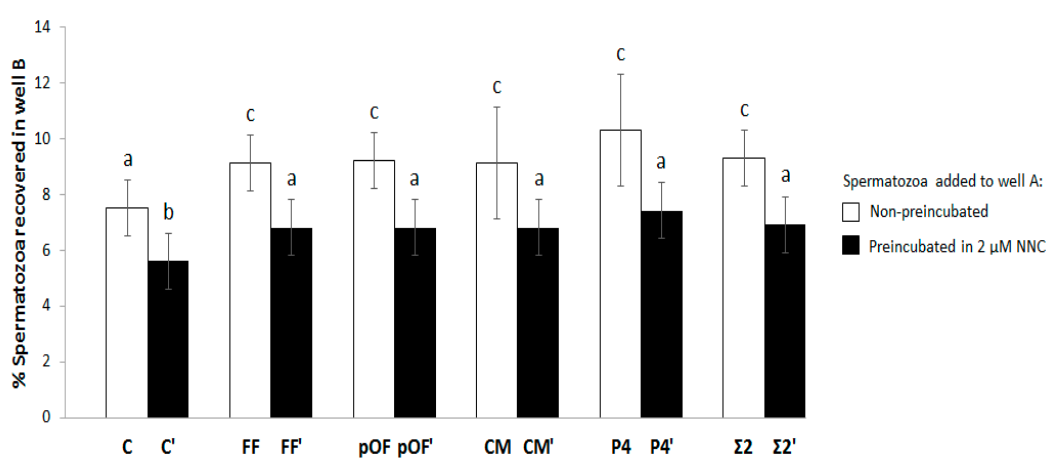
Figure 4. Chemotactic potential of chemoattractants and mechanism of action through CatSper. The percentage of spermatozoa attracted by the most effective concentration of each chemoattractant (0.25% FF, 0.25% pOF, 0.06% CM, 10.00 pM P4) was determined. That parameter was compared Table 10. min with 2 µ M of the CatSper inhibitor NNC 55-0396 [28] (FF’, pOF’, CM’, P4 ′ ). The combination of the most effective concentration of chemoattractants according to experiment 1.1 (Figure S2; Σ 2 and Σ 2 ′ ) was included in this study. The groups in which there was not a supplementation of chemoattractant in well B for selecting spermatozoa were included as control (C and C’). The results are expressed as man ± SEM. Four replicates were performed. Different letters (a–c) indicate statistical differences between groups ( p < 0.05).